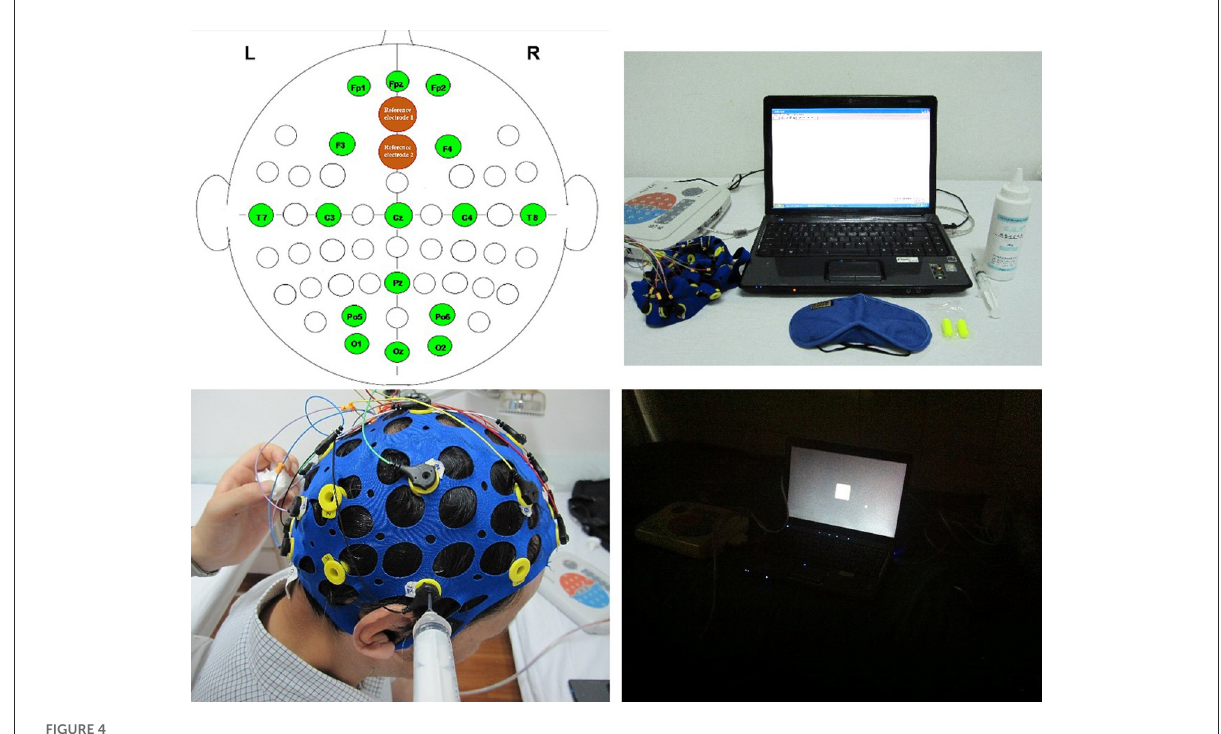
FIGURE4 Equipment and data acquisition of SSVEP.